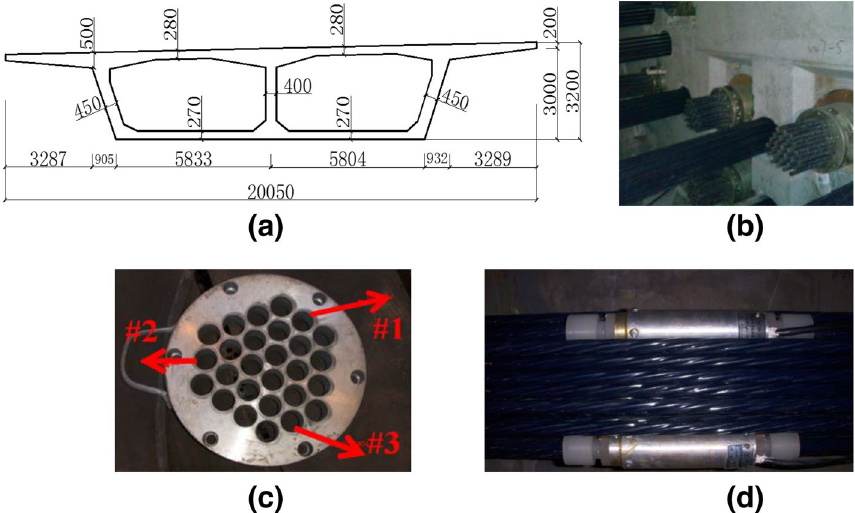
Fig. 3 Monitoring of the steel strands in the bridge (unit: mm): a representative cross section of the girder, b external prestressing strands, c layout of monitoring points, and d EME sensors during the